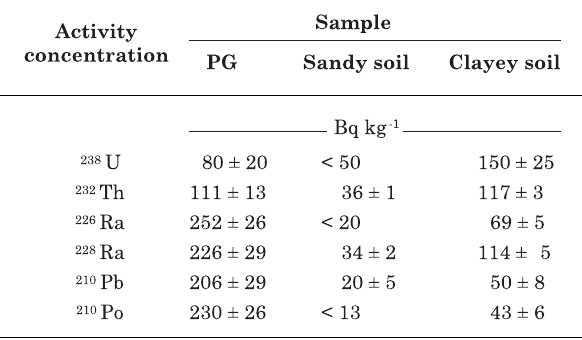
Table 3. Natural radionuclide activity concen- trations